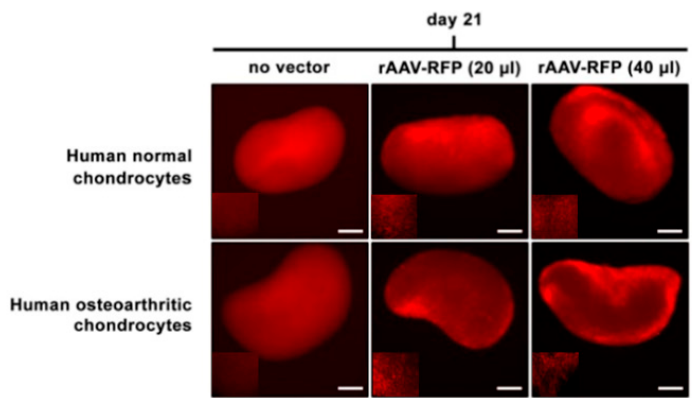
Figure 1. Over time transgene (red fluorescent protein, RFP) expression in recombinant adeno-associated viral (rAAV)-transduced aggregate cultures of human normal and osteoarthritis (OA) chondrocytes. Cell aggregates were transduced with rAAV-RFP (20 or 40 μ L) versus lack of vector treatment as described in the Materials and Methods. RFP expression was monitored at the denoted time points by analysis of live fluorescence with regular light overlay (RFP expression can be visualized by fluorescent dots in individual cells in the insets of day 21 at magnification x20) as described in the Materials and Methods (all representative data). Scale bars: 50 μ m.